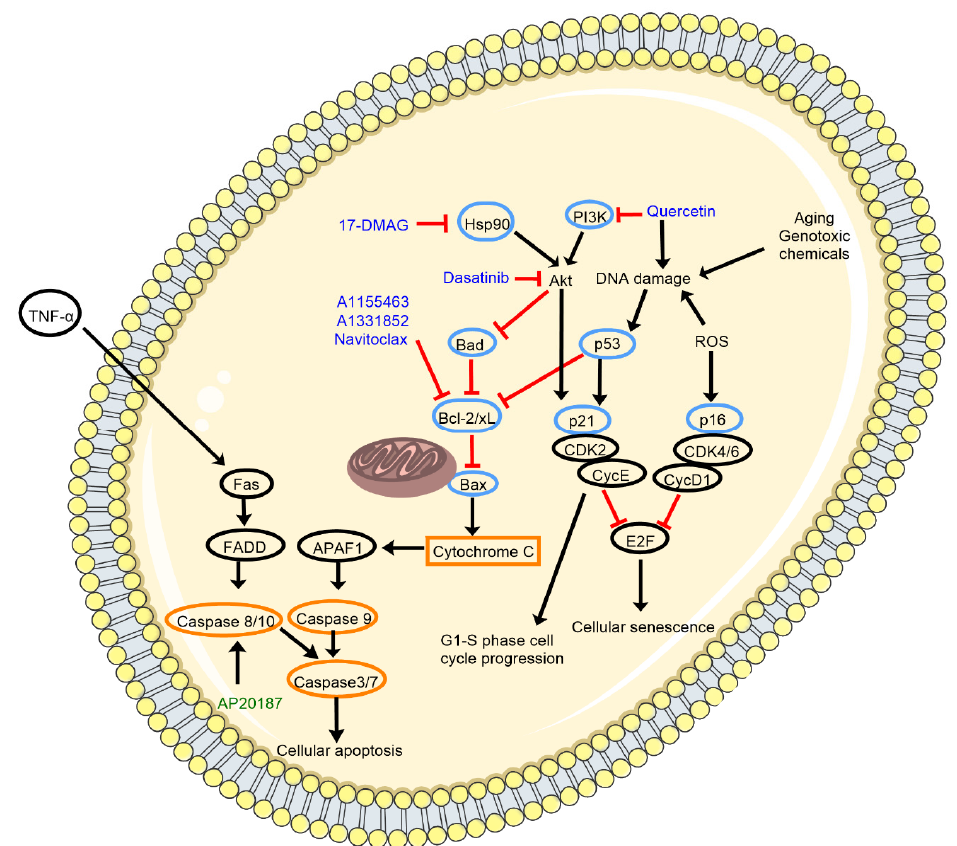
Figure 1. Simplified schematic of signaling pathways involved in senescence and senolysis. Stimuli such as aging, genotoxic chemicals and reactive oxygen species (ROS) activate key targets such as p53, p21, and p16. This results in senescence via interactions with cyclins and cyclin-dependent kinases, and resistance to apoptosis via inhibition of the Bcl-2/Bcl-xL pathway. Important protein targets and apoptotic signaling molecules are identified with blue and orange outlines, respectively. Senolytic drugs are annotated in blue text. A tool to trigger senolysis in the INK-ATTAC model is noted in green text. Black arrows represent activation. Arrows do not always indicate direct activation. Red blunted-ended lines represent inhibition. Hsp90: heat shock protein 90; PI3K: phosphoinositide 3-kinase; Bad: Bcl-2-associated death promoter; Bcl-2: B-cell lymphoma 2; Bcl-xL: B-cell lymphoma extra-large; ROS: reactive oxygen species; CDK: cyclin-dependent kinase; Cyc: cyclin; APAF1: apoptotic protease activating factor 1; TNF- α : tumour necrosis factor α ; FADD: Fas-associated death domain.